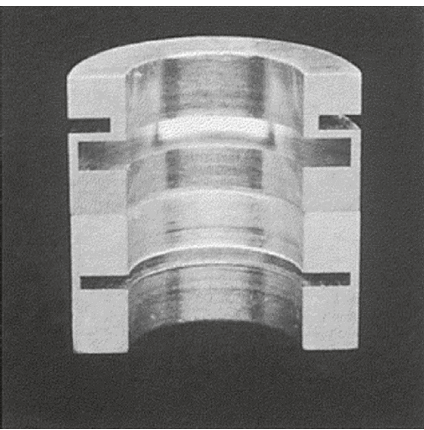
Figure 14: The pulse shaper for TSHB